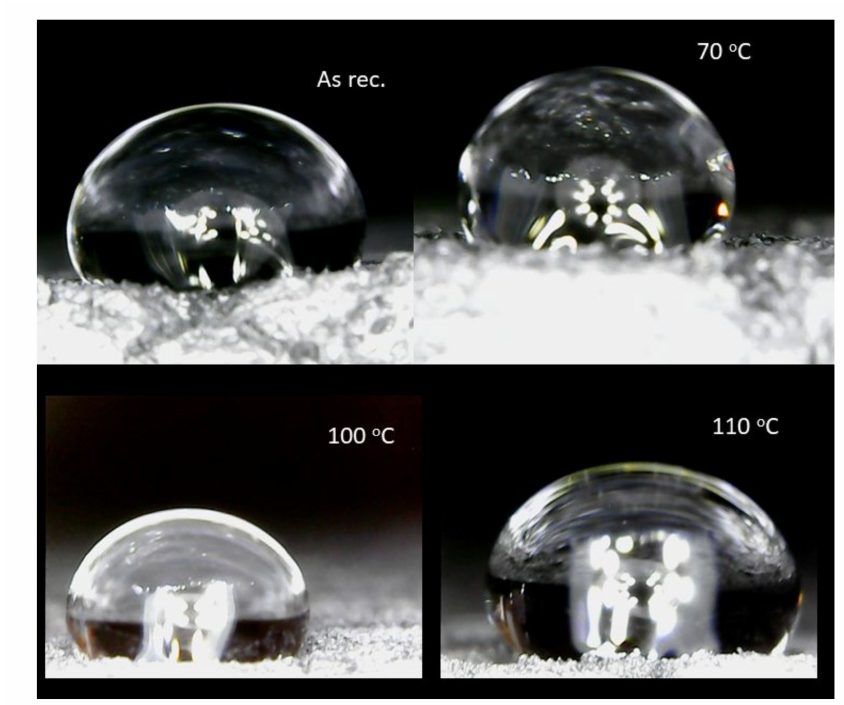
Figure 10. The hydrophobic